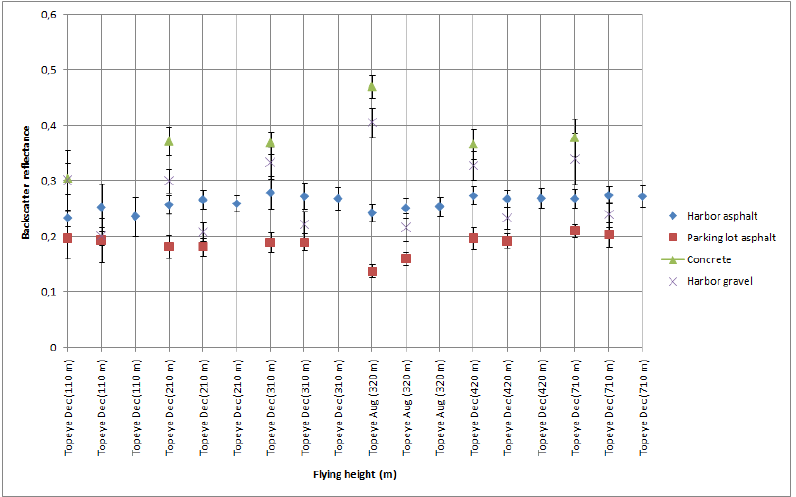
Figure 6B. Backscatter reflectance values calibrated with 45% tarp. The intensity values at 320 m flight altitude are relative to 30% tarp. Data points from heights 110 m, 210 m,